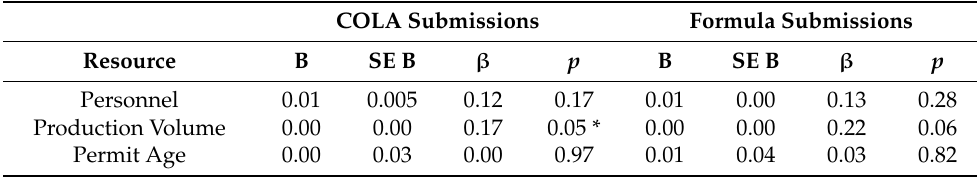
Table 14. Prediction of Regulatory Perception Score Using Brewery